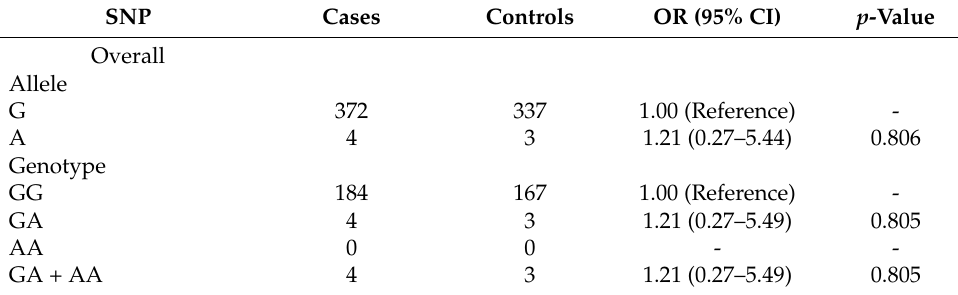
Table 3. Association of the β -like globin G79A SNP with malaria